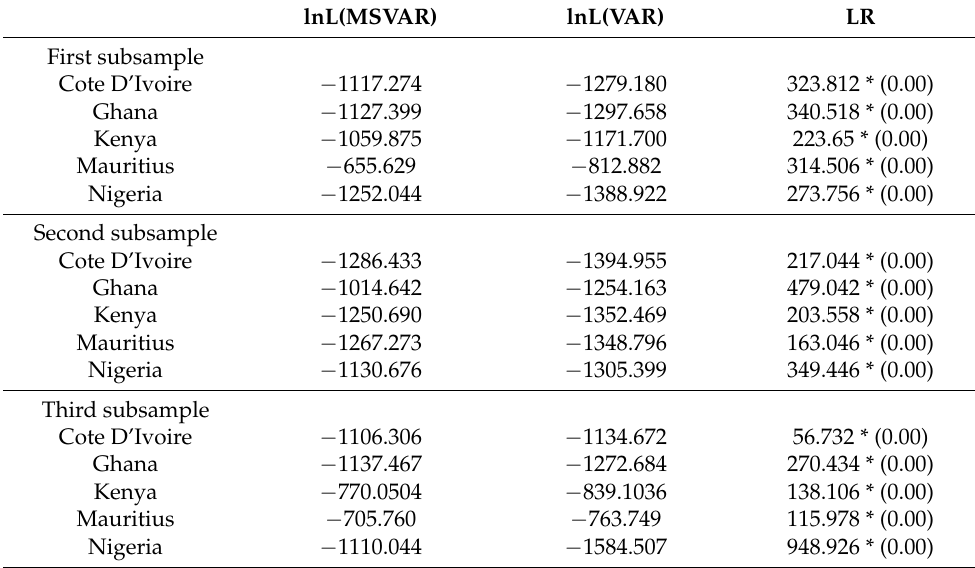
Table 11. Subsample LR